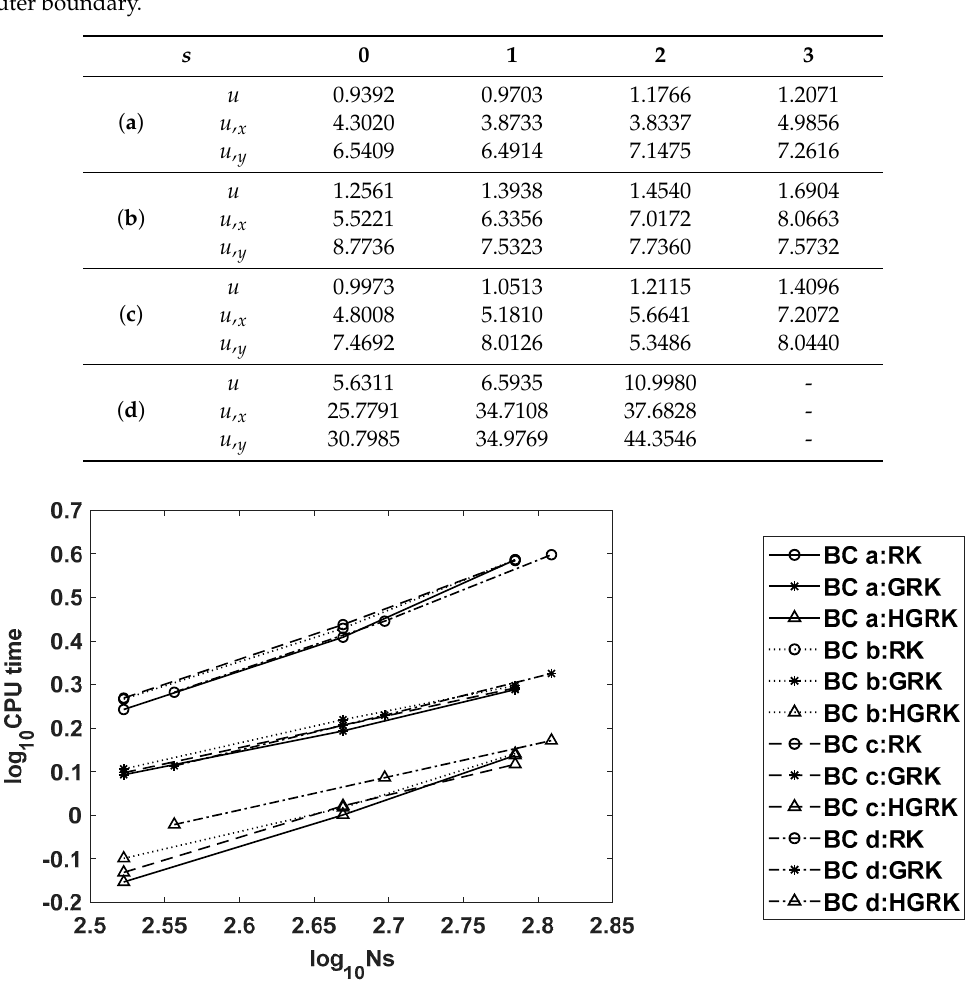
Figure 18. Comparison of CPU time by different methods in the multiply connected domains: type two.